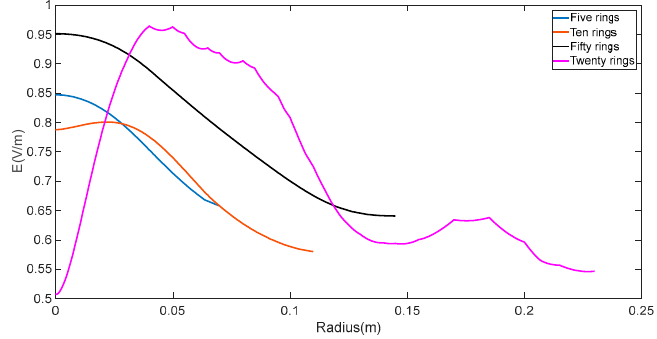
Figure 13. Radial profile of the electric field for a dry poplar sample with a 50% dielectric constant variation between growth rings.